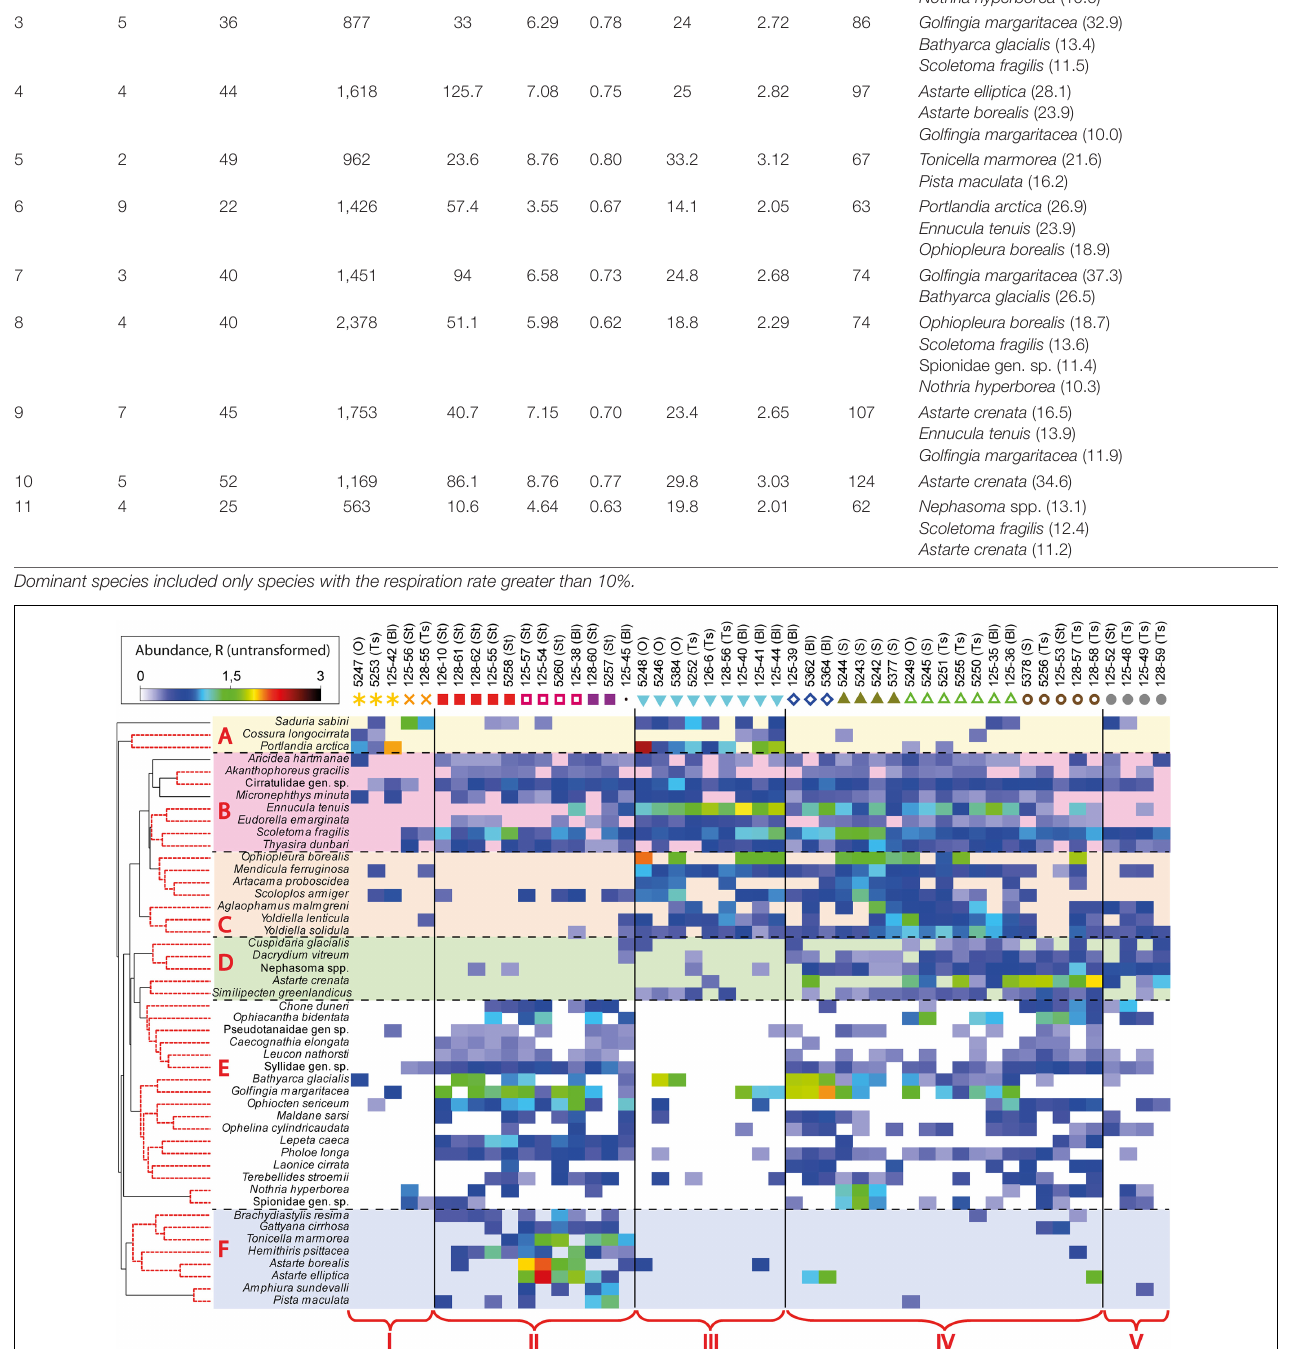
Frontiers in Ecology and Evolution |